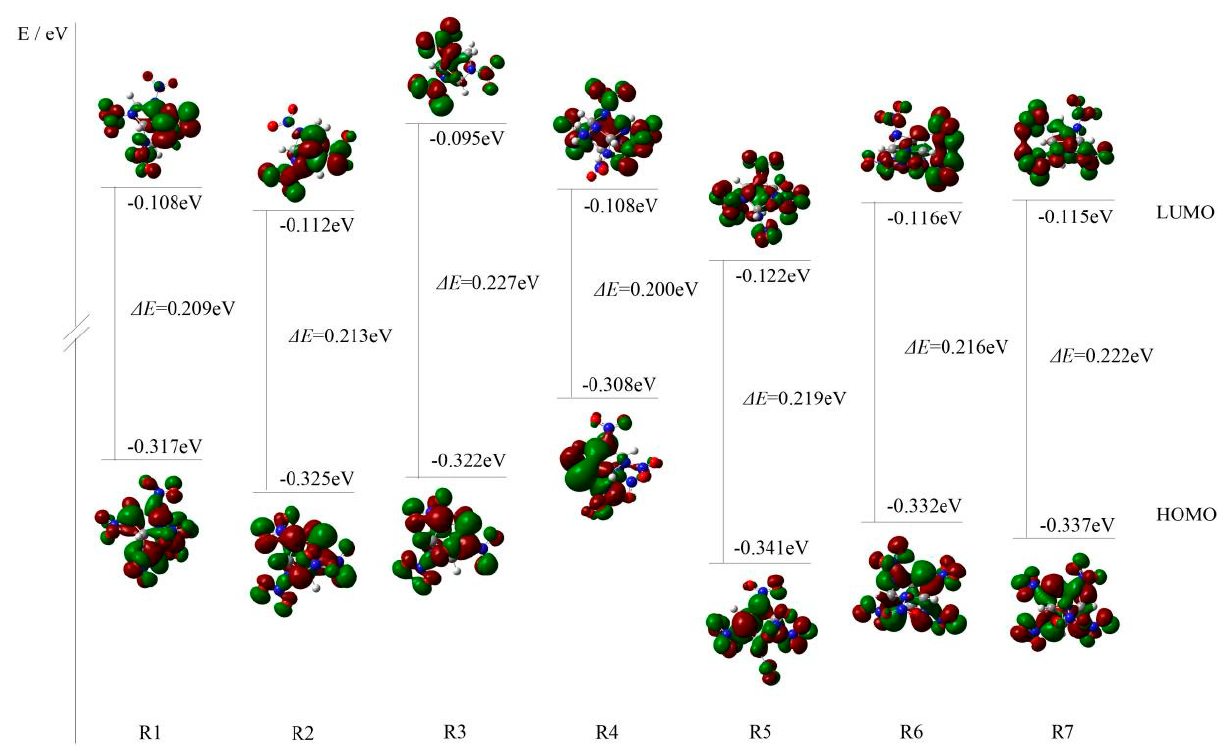
Figure 3. HOMO and LUMO energy levels and energy gaps of seven designed compounds. have greater positive potential in the molecules [25]. Figure 4 outlines the molecular electrostatic potentials (MEPs) of the 0.001 electron/bohr 3 electron density isosurface of the title compounds. The red color represents negative potential and blue signifies positive potential with the range from − 0.03 to +0.05 hartree. Based on the MEPs of the designed compounds, the positive potentials are at the center of the bicyclic or cage, whereas the negative potentials locate on the NO 2 . Among these compounds, R4, R5, R6, and R7 have more positive potential than the other three compounds, which may lead to higher sensitivity.